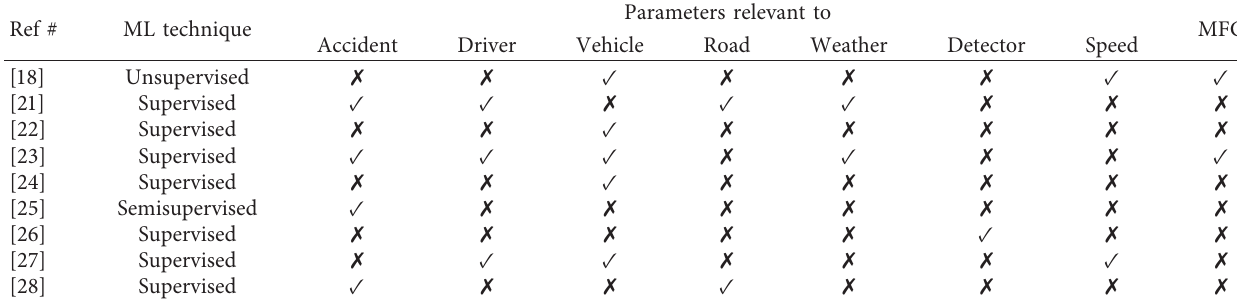
Table 1: Summary of accident detection systems.